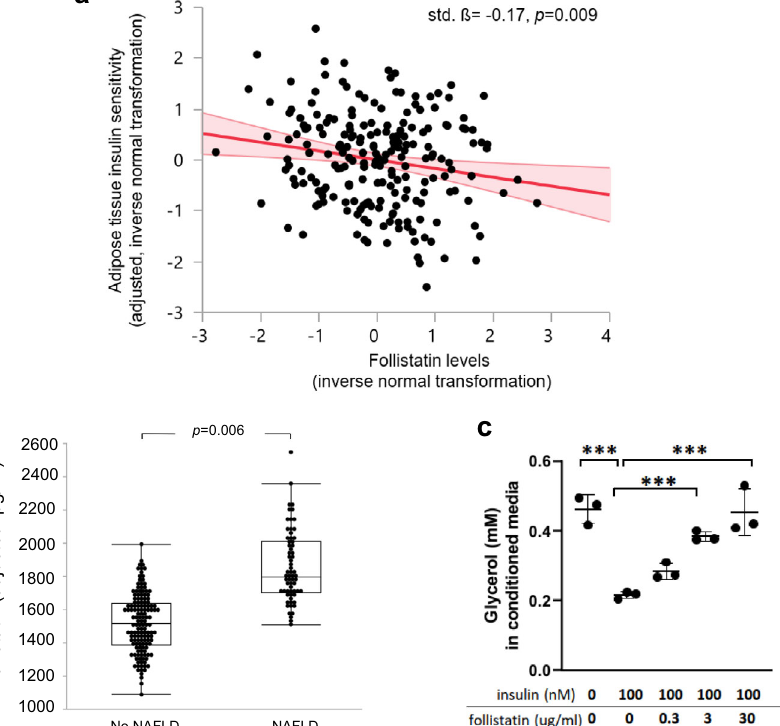
Fig. 2 Association of follistatin with adipose tissue insulin resistance and nonalcoholic fatty liver disease (NAFLD). a Relationship of adipose tissue insulin sensitivity, adjusted for age, sex, and total body fat mass, with follistatin levels, in a multivariate linear regression model in the Tübingen Diabetes Family Study (TDFS) cohort ( n = 210). Depicted is the regression line and the 95% CIs. b Relationship of follistatin levels, adjusted for age, sex, and total body fat mass, with NAFLD, in a multivariate logistic regression model (TDFS, n = 210). c Human adipose-derived stem cells (Lonza) were differentiated into adipocytes (see details in Methods). Cells were maintained in insulin-free media overnight and treated with 0, 0.3, 3, and 30 µ g/mL follistatin for 2 h followed by addition of 100 ng/mL insulin for 3 h. Breakdown of triglyceride released glycerol and free fatty acids (FFAs), and lipolysis was determined by measuring media glycerol content. Three independent experiments ( n = 3) were performed. Statistical signi fi cance was determined by Tukey – Kramer HSD using JMP 14.1.0. *** p < 0.001 as